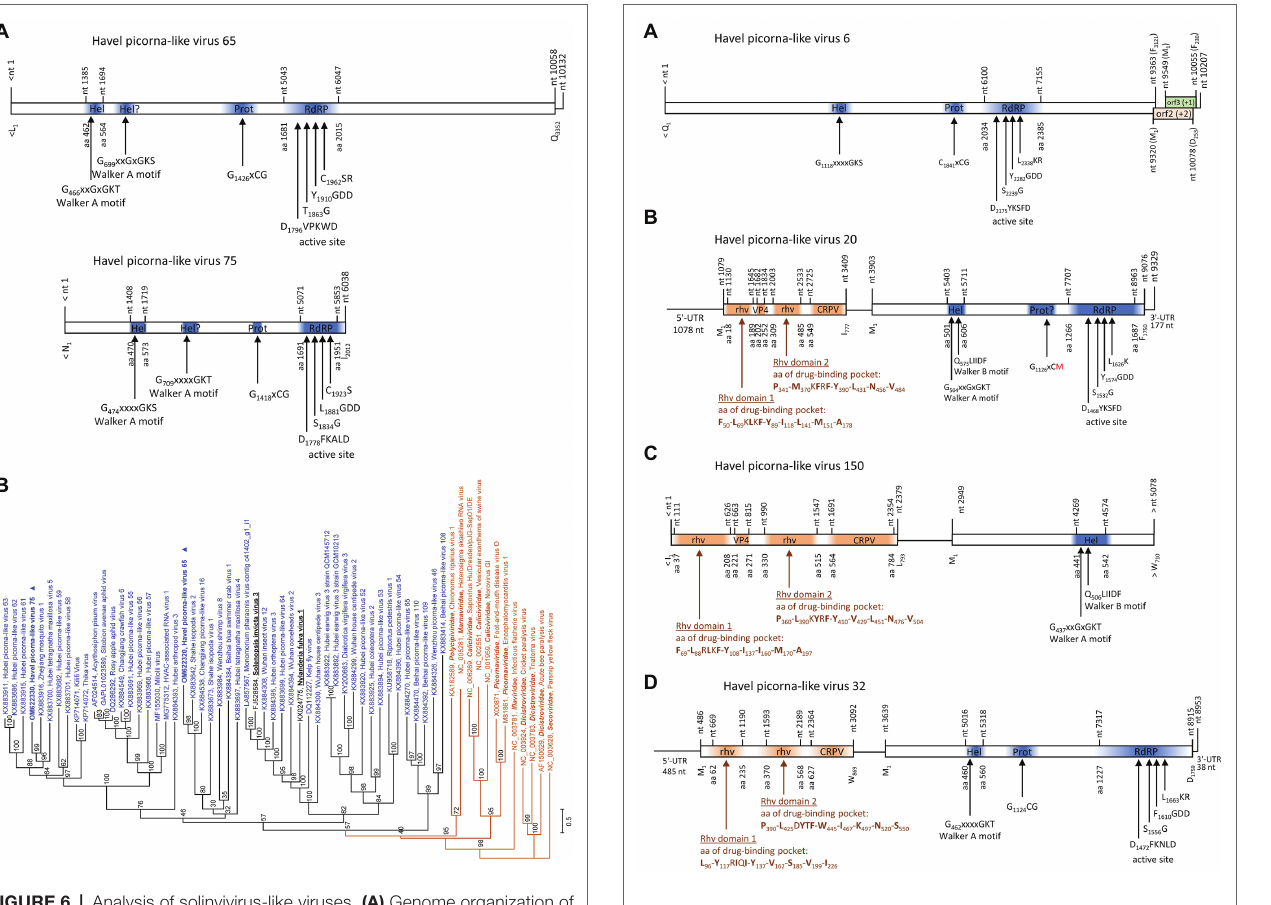
FIGURE 7 | Viruses with unusual genome layout. Genome organization of Havel picorna-like virus 6 (A) , − 20 (B) , − 150 (C), and − 32 (D) . Conserved domains and sequence motifs were identified by searching the NCBI Conserved Domain Database (https://www.ncbi.nlm.nih.gov/Structure/cdd/ wrpsb.cgi). UTR, untranslated region; Hel, helicase; Prot, proteinase; RdRP, polymerase; rhv, capsid protein with similarity to the rhinovirus capsid protein with jelly roll fold and drug-binding pocket; VP4, viral protein 4; and CRPV, capsid protein with similarity to the cricket paralysis virus capsid